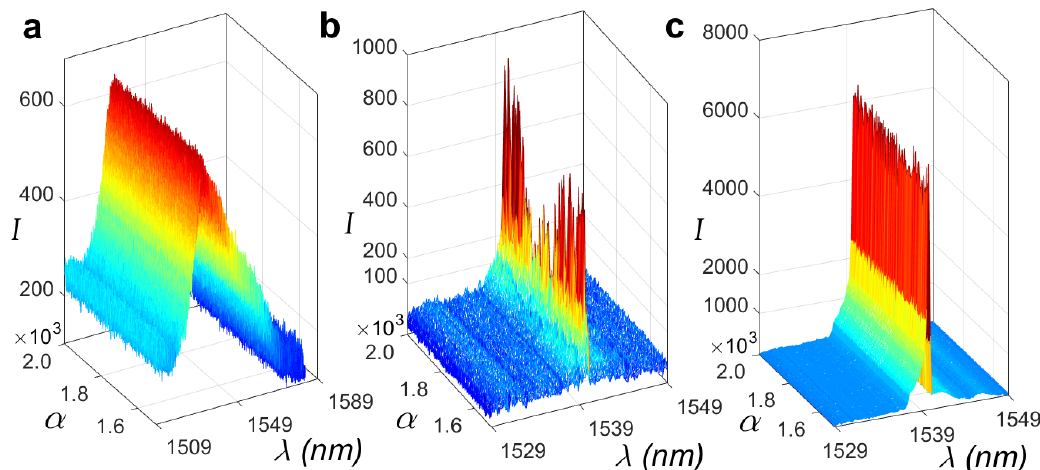
Figure 2. Plots of 500 emission spectra at each excitation power below [( a ) P / P th = 0.72], near [( b ) P / P th = 0.99], and above [( c ) P / P th = 2.92] the RFL threshold [11,12]. Intensity